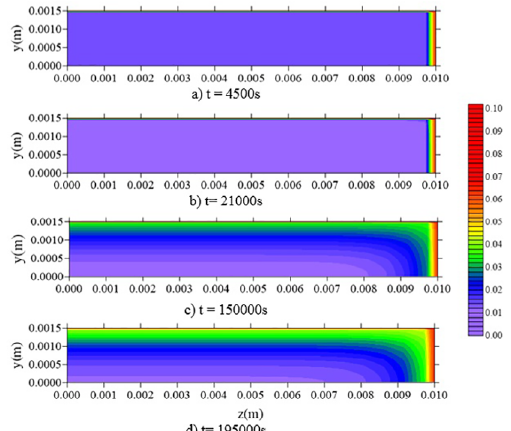
Figure 11. Distribution of the entrapped solute concentration (S) in z = R /2 plane for different water absorption times. z